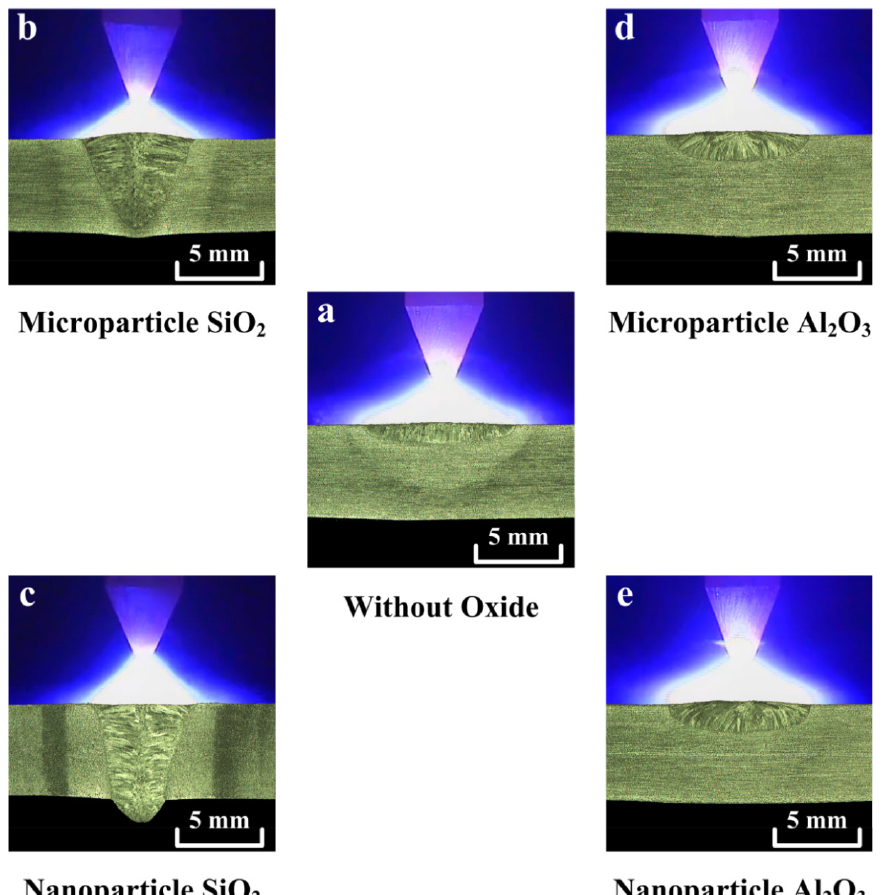
Figure 5. Weld shape and arc plasma of TIG welding with and without